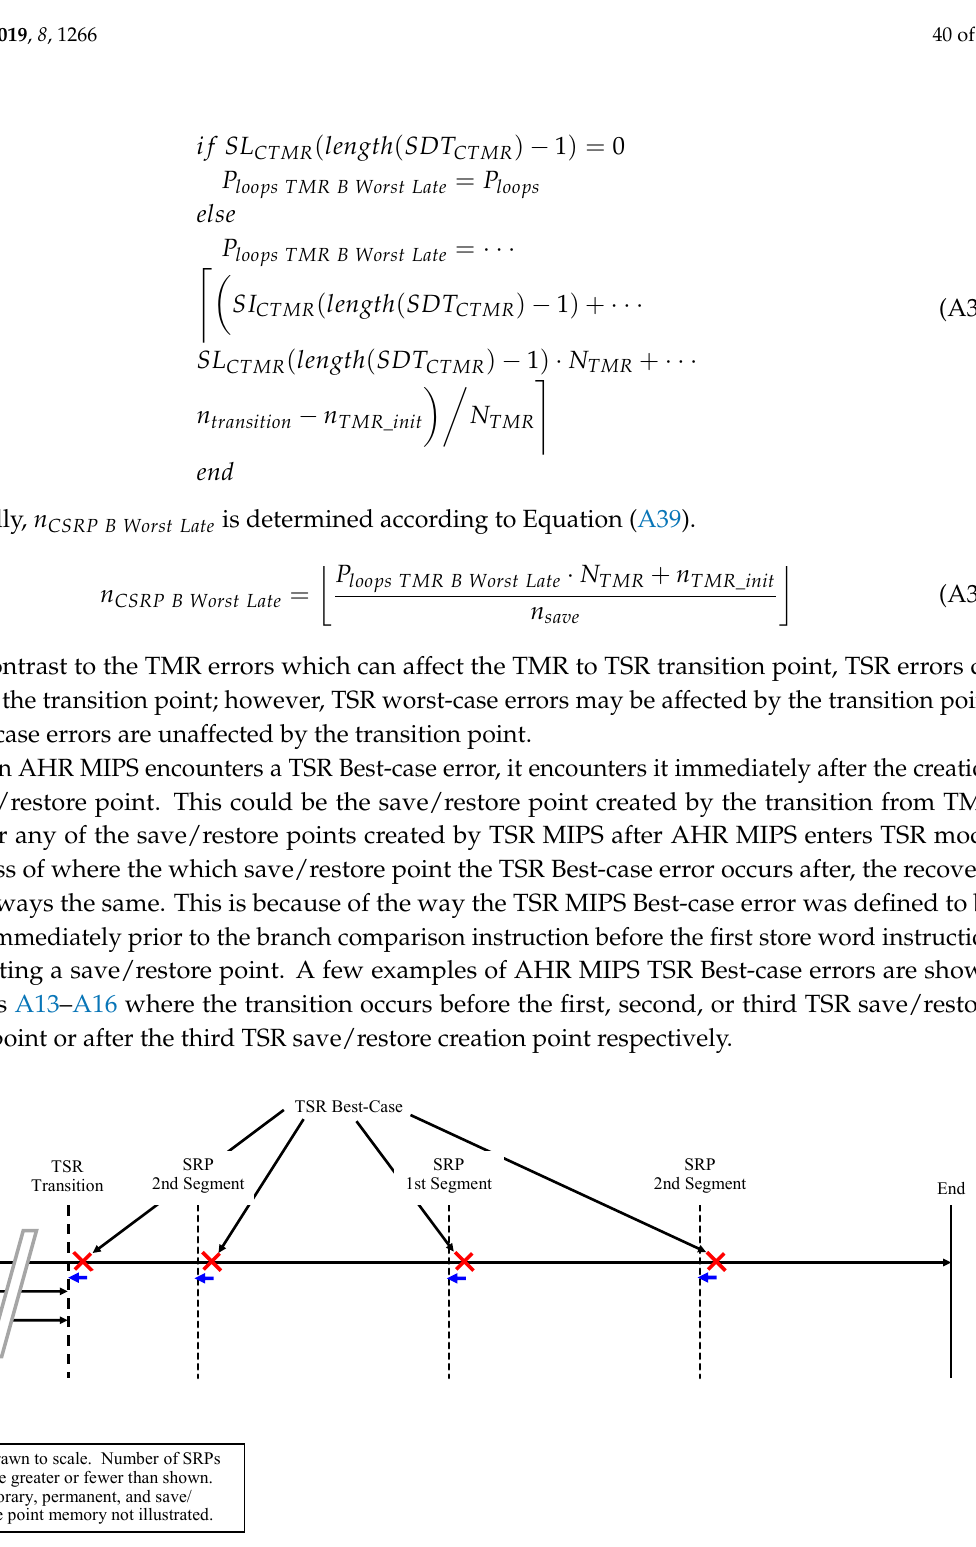
Figure A13. AHR MIPS TSR Best-Case Early Error Timing Diagram